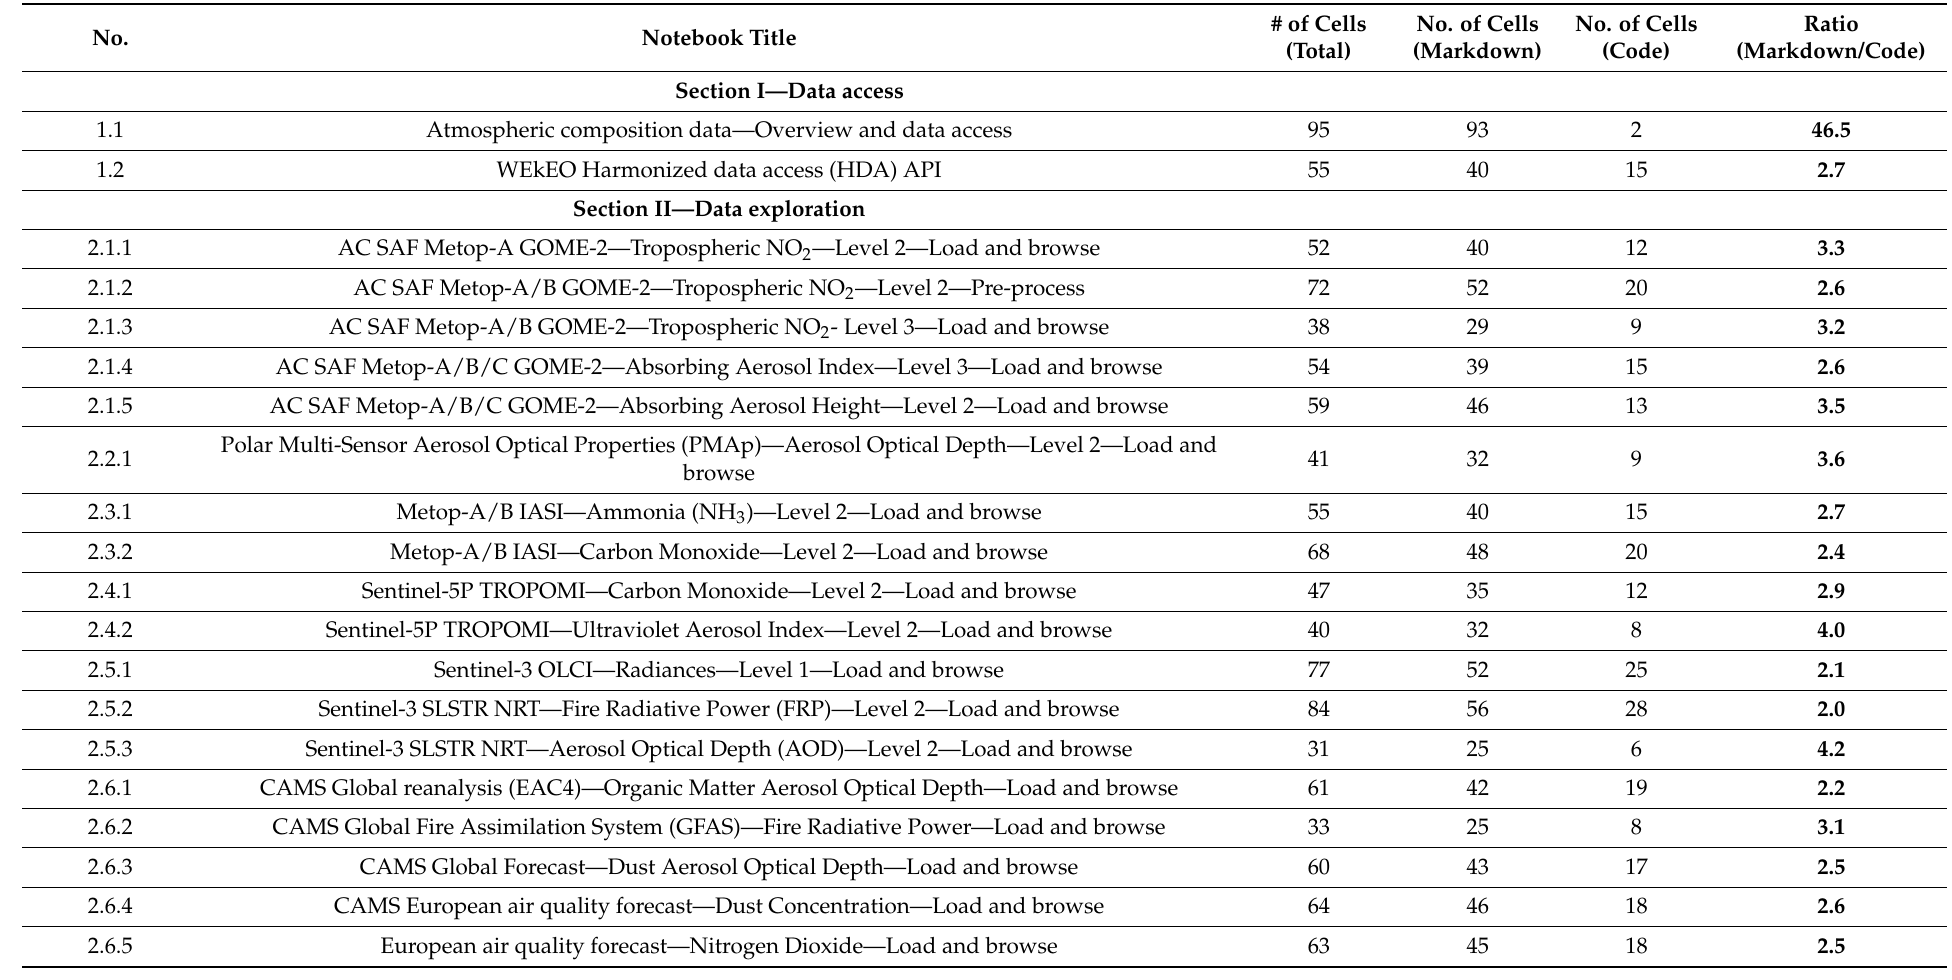
Table A5. Overview of notebooks that are part of the LTPy main course and, for each notebook, the number of cells in total, number of markdown cells, number of code cells and the markdown/code ratio are